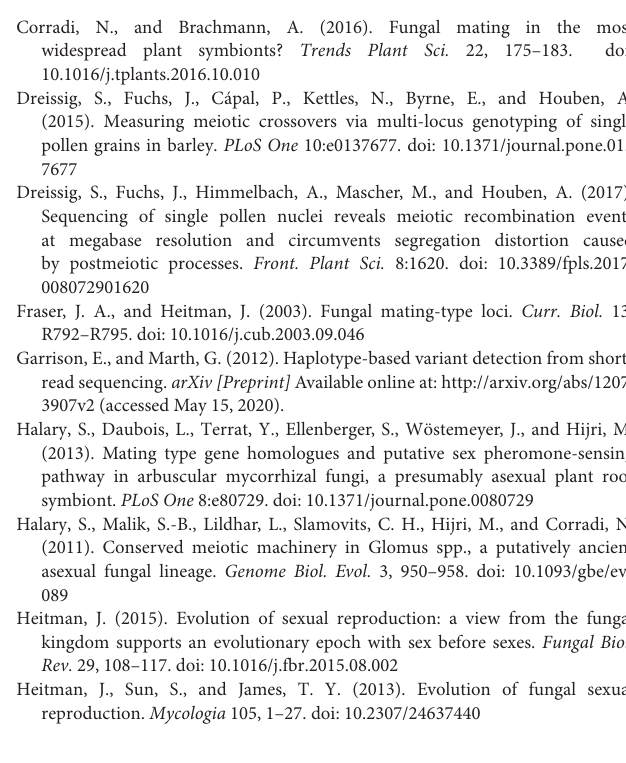
TABLE S1 | Genotype file with minimum coverage of 5, with heterozygous sites as defined in Chen et al. (2018b) and Auxier and Bazzicalupo (2019) removed, and single-copy regions. Yellow and Green colors highlight the two co-existing